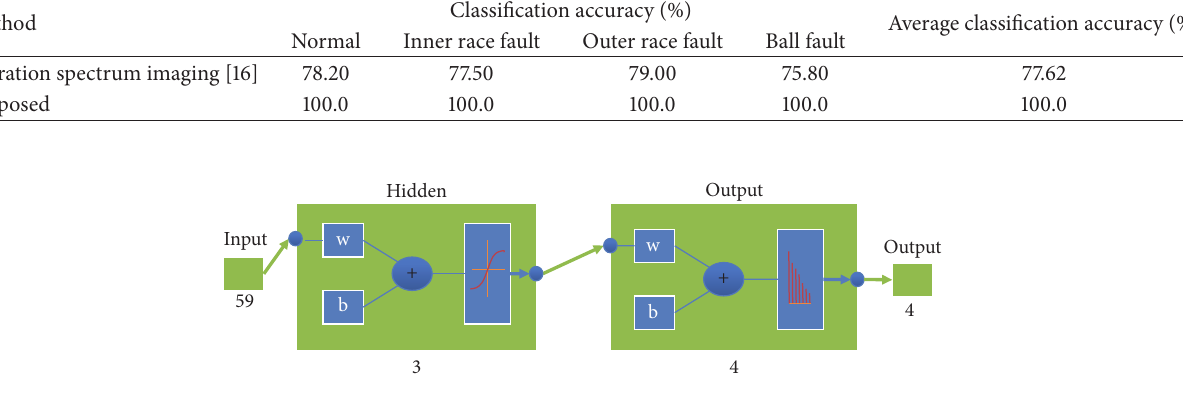
Figure 7: The artificial neural network used for fault diagnosis in bearings using the LBP